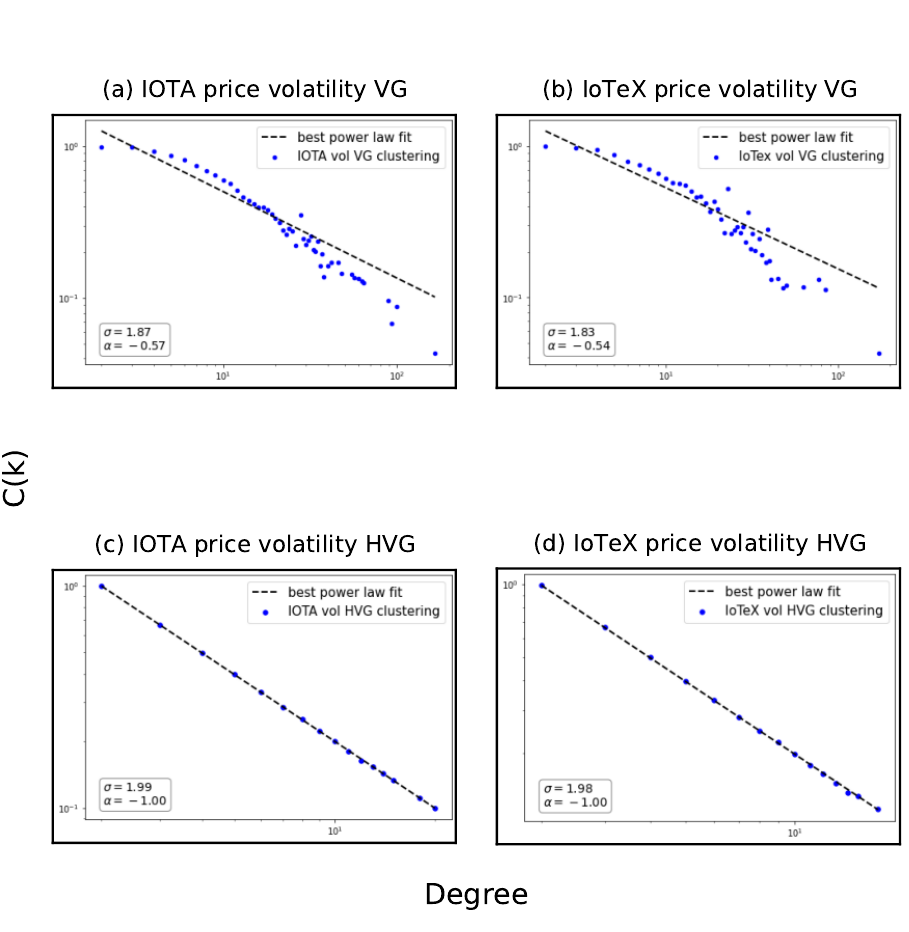
Figure 5. Best power law fit using curve_fit with the average of clustering coefficients per degree for ( a ) IOTA VG, ( b ) IoTeX VG, ( c ) IOTA HVG and ( d ) IoTeX